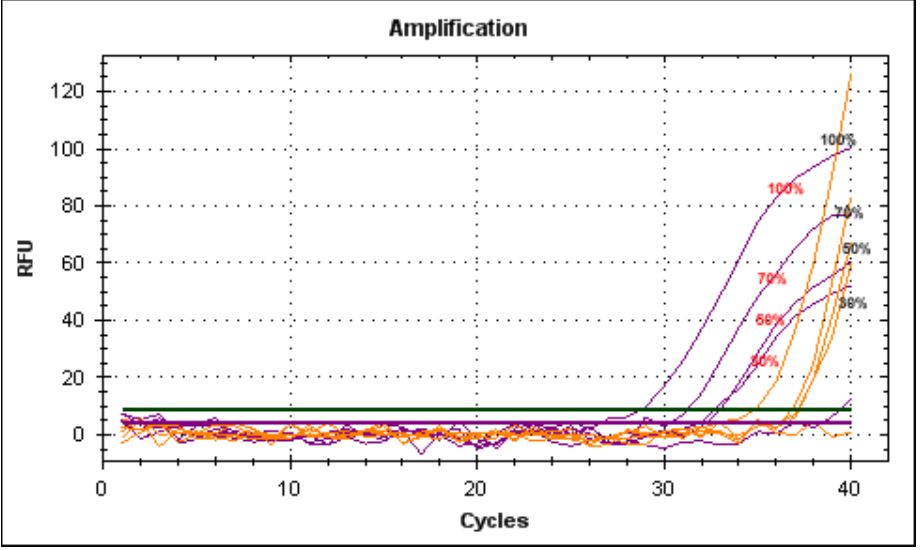
Figure 6. Multiplex real-time PCR carried out with dual labeled probes on DNA extracted from blueberry and orange juices mixed at different